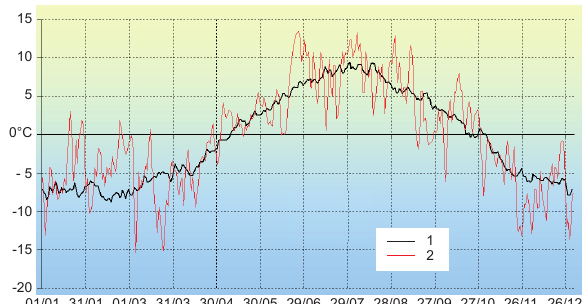
Fig. 11. Air temperature at Grand St Bernard pass (2472ma.s.l.; data from MeteoSwiss). 1: 1960–2007 average of the mean daily air temperature; 2: 2008 mean daily air temperature.